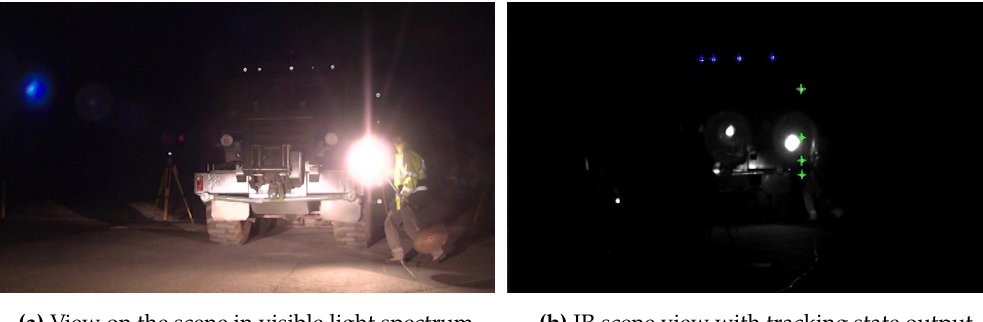
Figure 32. The vertical target is successfully identified (yellow crosses) despite occlusions.